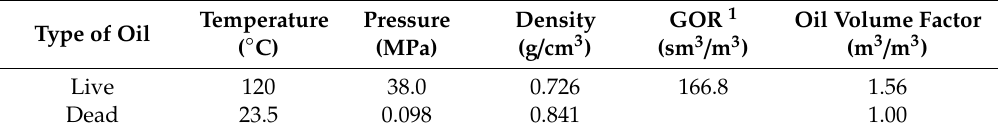
Table 4. PVT data of crude oil used for core floods experiments.